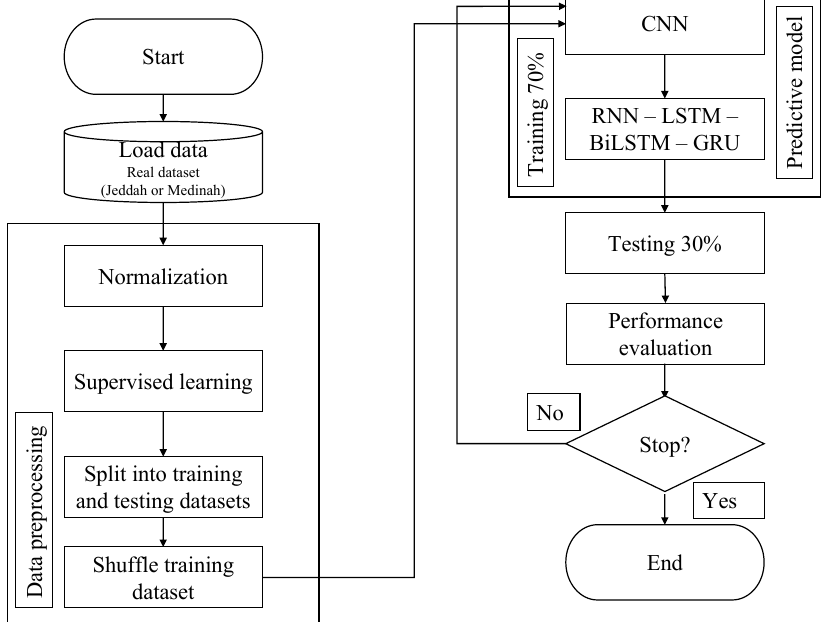
Figure 9. Proposed hybrid DL algorithms flowchart for load-forecasting modeling.